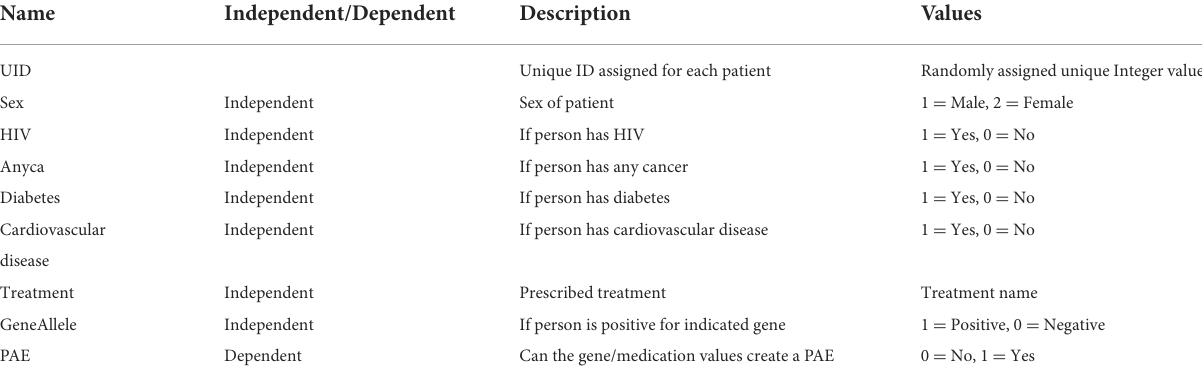
TABLE 1 Finalized variables in dataset after